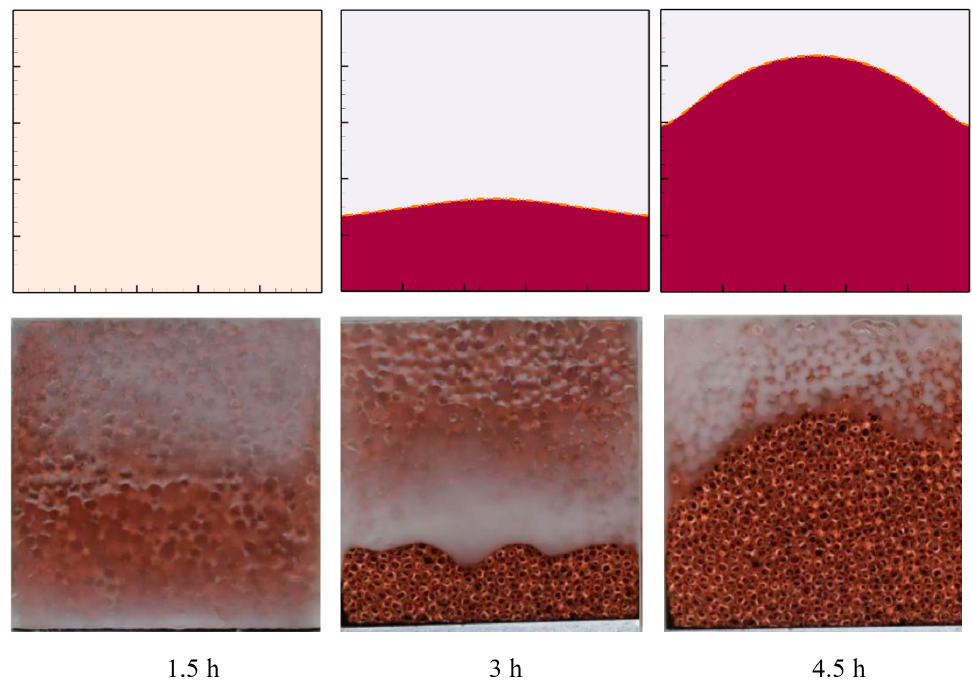
Figure 5. The melting interface shapes simulated in the current study and the experimental reports adapted with permission from Ref. [63] . 2018, Elsevier.